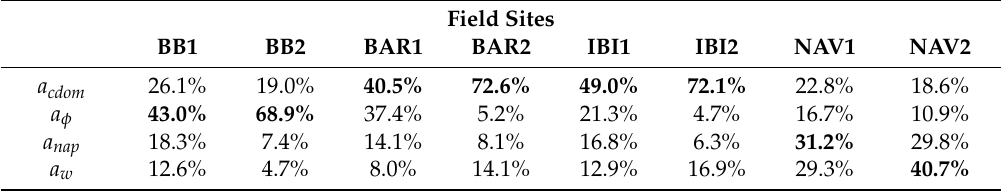
Table 3. Mean contribution of a cdom , a φ , a nap , and a w to a t within the 400–700 nm of range (PAR